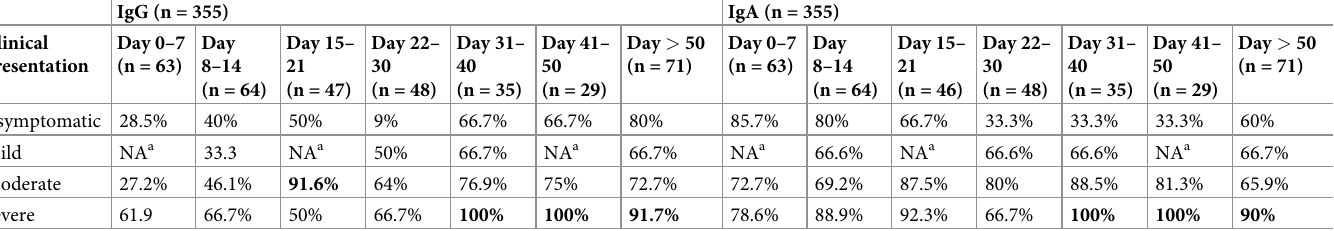
Table 3. Assay performance of EUROIMMUN Anti-SARS-CoV-2 IgA and IgG Assay compared with PCR according to timepoint post-PCR diagnosis and disease severity.